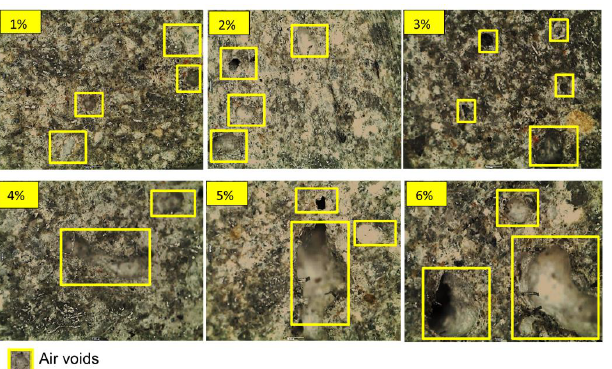
Figure 5. The appearance of air voids in samples with various CSWF distributions (1%, 2%, 3%, 4%, 5%, and 6%).